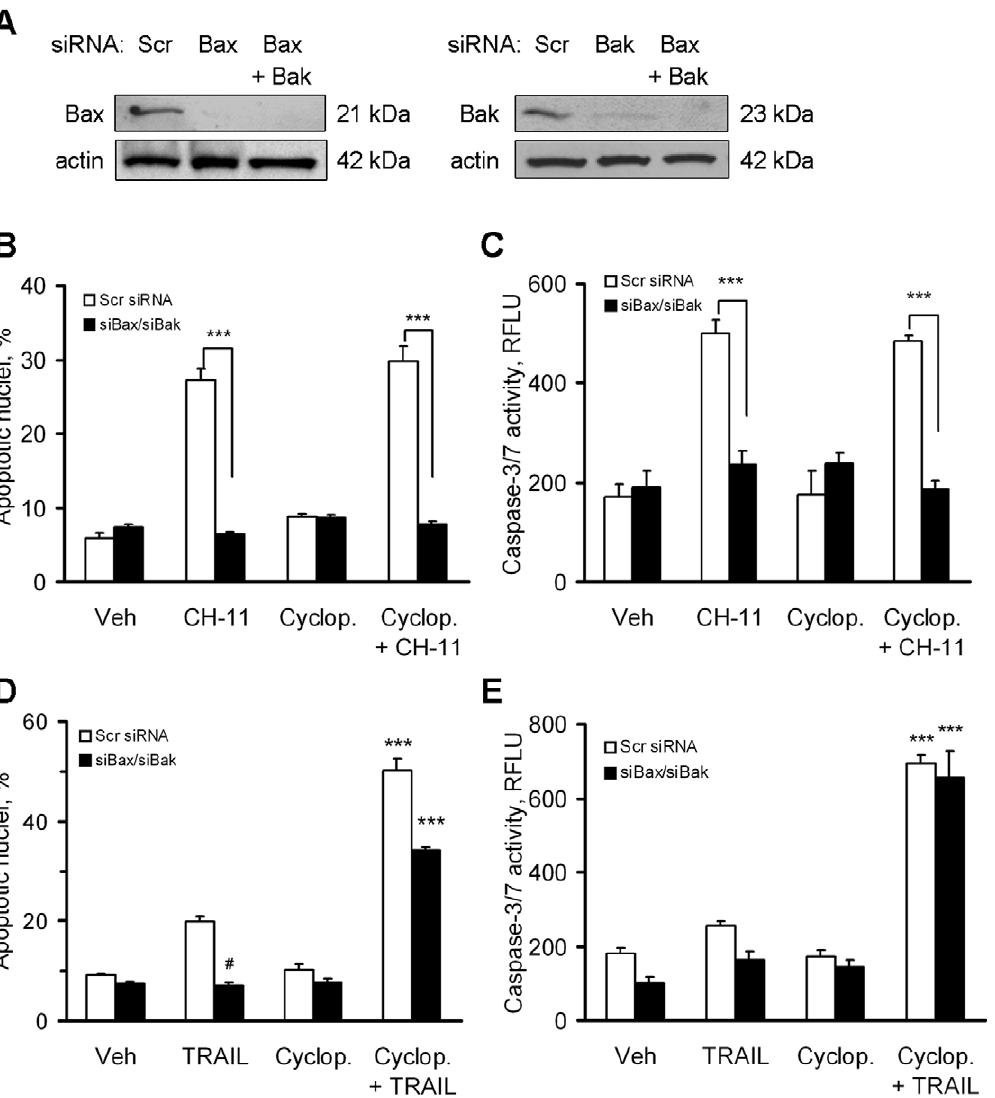
Figure 4. Cyclopamine sensitizes cells to TRAIL-induced cell death independent of Bax and Bak. A, Whole cell lysates from KMCH cells transiently transfected with specific siRNA targeting Bax and/or Bak or scrambled siRNA were obtained 48 hours after transfection and analyzed by immunoblot using anti-Bax or anti-Bak antisera. Actin was used as a loading control. B , KMCH cells transiently transfected with Bax- and Bak-siRNA or scrambled siRNA were pretreated (24 hours) with medium or cyclopamine (5 m M) as indicated, then treated with Fas agonistic antibody CH-11 (100 m g/mL) for 5 hours. Cells with apoptotic nuclear morphology were counted. Mean + / 2 SEM; ***p , 0.001. C, KMCH cells were treated as in panel B and caspase-3/7 activity was measured after 5 hours. Mean + / 2 SEM; ***p , 0.001 D , KMCH cells transiently transfected with Bax- and Bak-siRNA or scrambled siRNA were pretreated with vehicle or cyclopamine (5 m M) for 24 hours, and then treated with TRAIL (5 ng/mL) for 5 hours. Cells with apoptotic nuclear morphology were counted. Mean 6 SEM, # p , 0.05 and ***p , 0.001 compared to cells transfected with scrambled siRNA and treated with TRAIL. E , KMCH cells transiently transfected with indicated siRNA and treated as in panel D , were assayed after 5 hours for caspase-3/7 activity. Mean 6 SEM; ***p ,